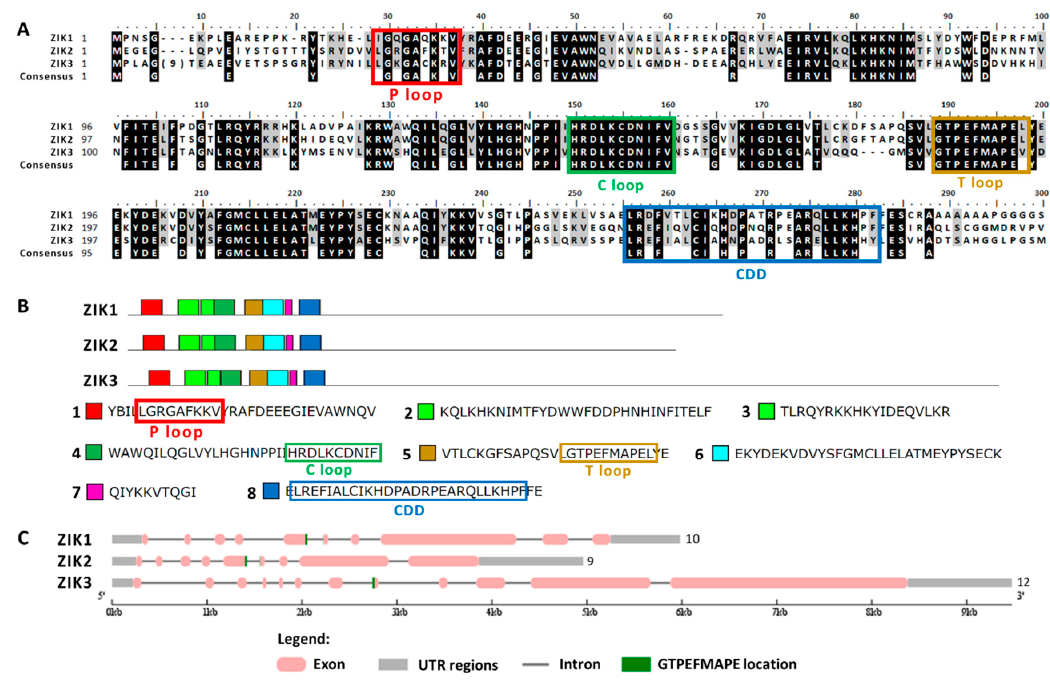
Figure 10. Sequence alignment and motif analysis of ZIK-type MAPKKKs. ( A ) Alignment of the 3 Chlamydomonas ZIK-type MAPKKKs identified. The P, C and T loops and the CDD are highlighted. ( B ) Domain analysis in MAPKKKs type ZIK. The 3 ZIK MAPKKKs are shown with the consensus sequence identified in MEME (the domains are listed in order of appearance from the N-terminal). ( C ) Analysis of the MAPKKKs ZIK gene sequence with the GSDS program. For other details see Figure 6.